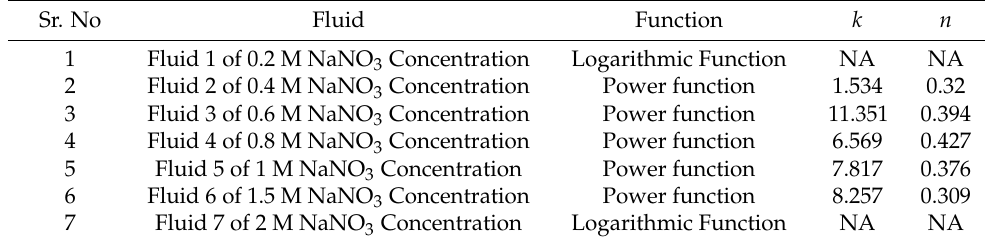
Table 1. Regression functions for viscosity change with a varying shear rate of different viscoelas- tic type1 fluids at Temperature 25 °C. Table 5. Consistency value k and flow Index value n for type1 fluids. Sr. No.